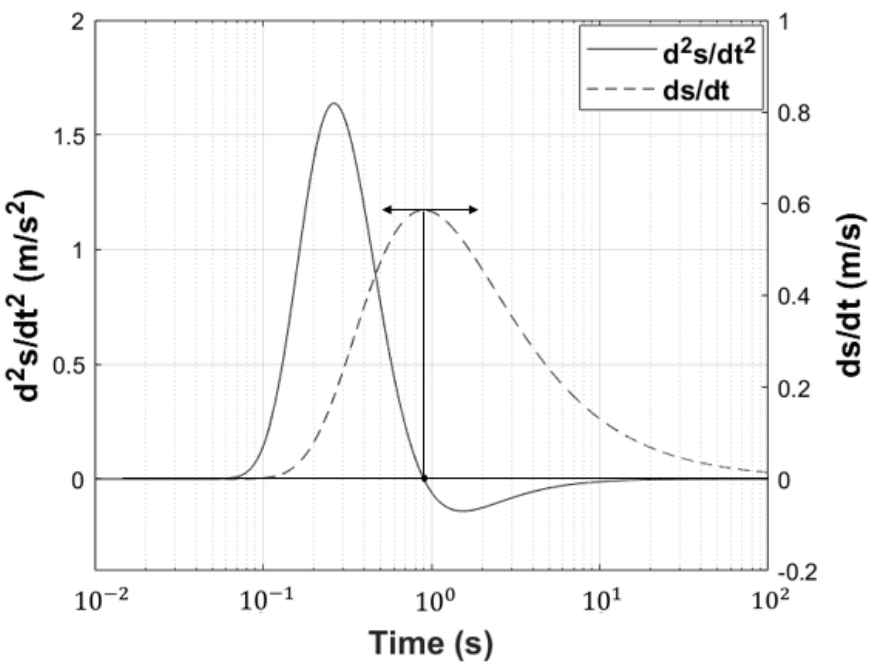
Figure 5. Representation of drawdown solution predicted by the Theis model and its first derivative functions versus time at the position r = 6 m, with Q = 0.18 m 3 / s , T = 0.01 m 2 / s and S = 0.001 .